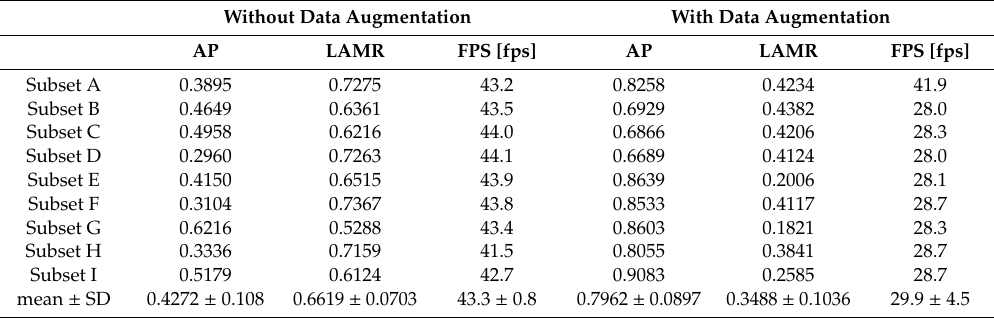
Table 1. Average precision (AP), log-average miss rate (LAMR), and frame per second (FPS) for 32 × 32-pixel ROIs.